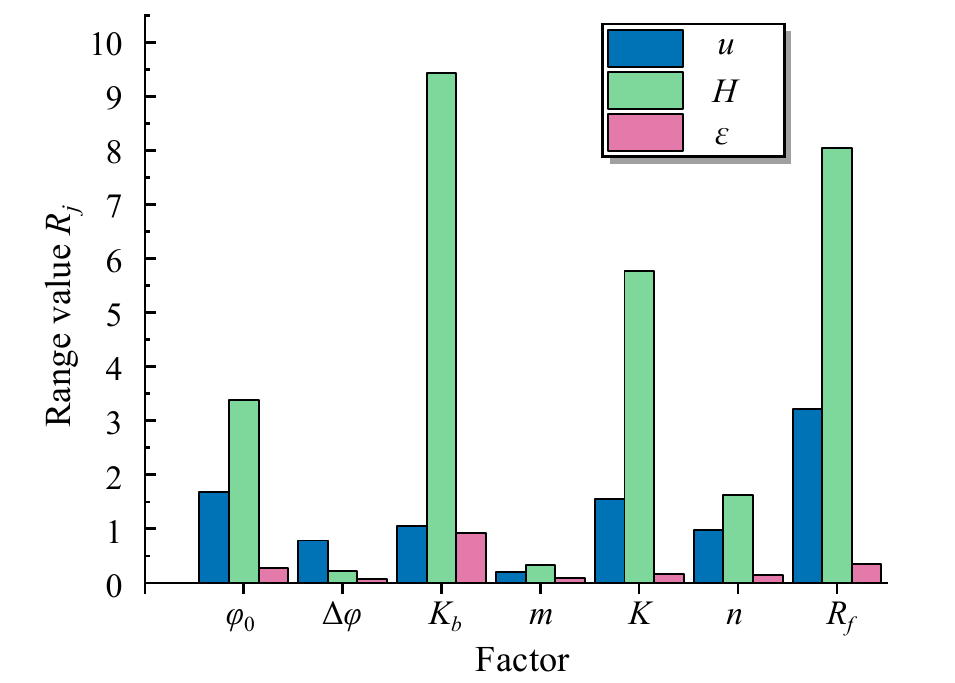
Figure 8. Sensitivity of each index for the main rockfill zone. Range Analysis for Secondary Rockfill Zone The range analysis method was used to process the results of each scheme in the three columns u , H , and ε in the summary table of the orthogonal test results in the secondary rockfill zone (Table 6). The range analysis results are shown in Table 9. Table 9. Range analysis results of influencing factors on each test index for the secondary rockfill